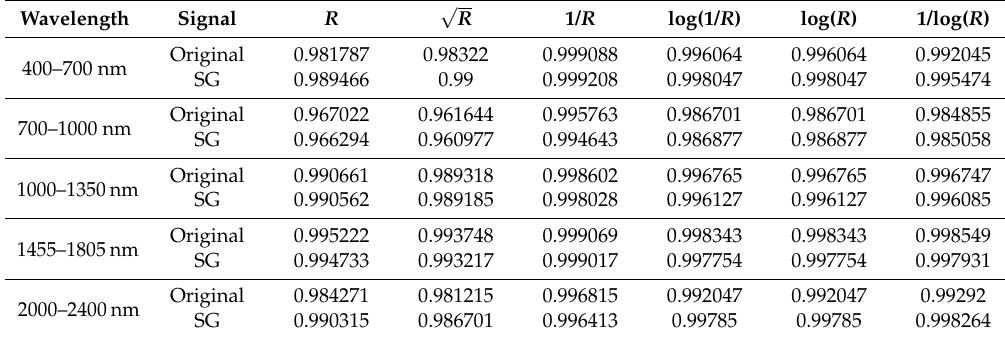
Table 5. The R 2 value of the PNN model in Area B.